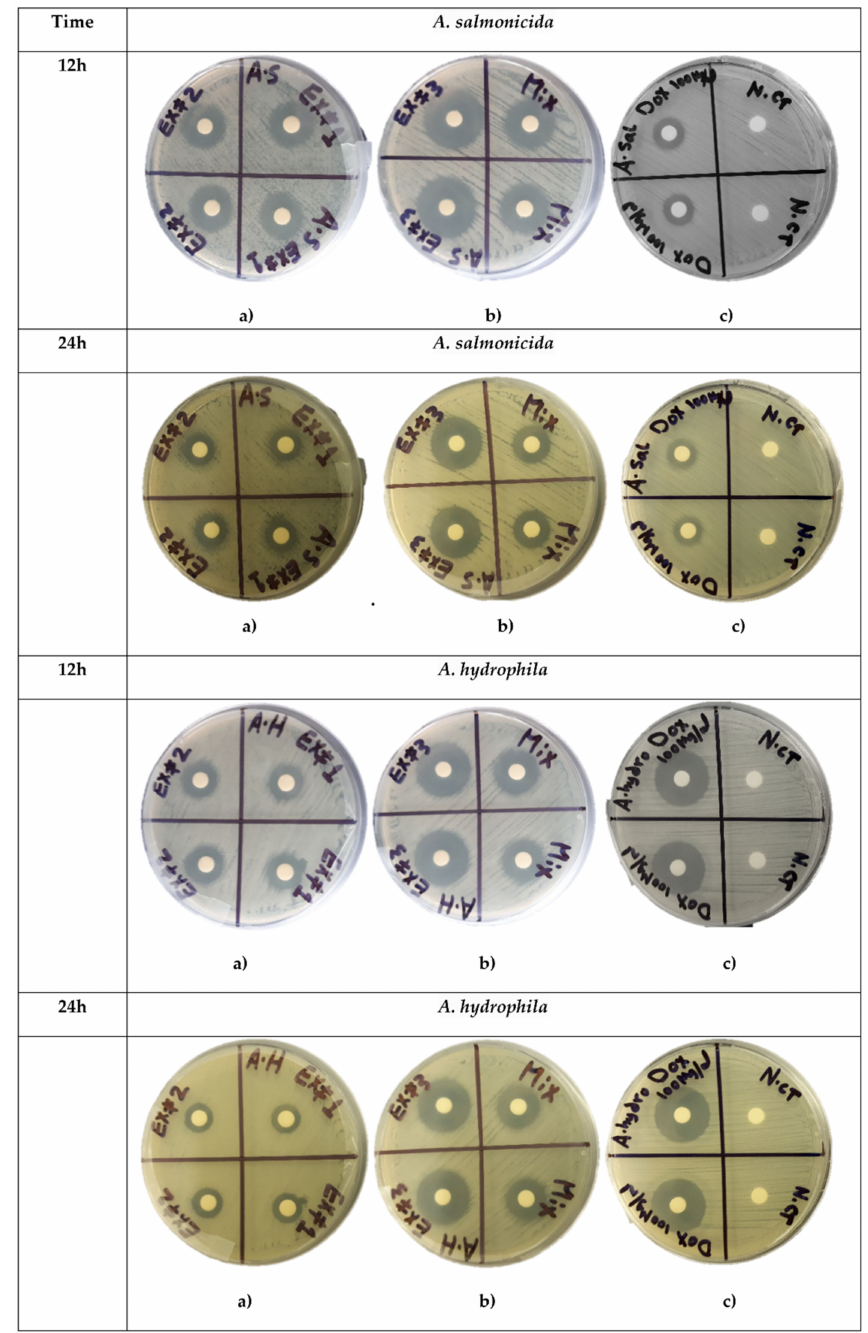
Figure 2. Susceptibility of A. hydrophila and A. salmonicida to three sequential extracts treatment determined by disk diffusion assay. Disks loaded in duplicates with 50 µ L of ( a ) AWME1 (Ex#1) and AWME2 (Ex.#2); ( b ) AWME3 (Ex.#3) and a mixture of the three SEs (Mix) at concentration 40 mg/mL; ( c ) Positive control (Doxycycline, 100 µ g/mL) and the extraction reagent as a negative control (N.ct). Inhibition Zone Diameter ranged from 11.4 ± 0.14 mm to 12.72 ± 0.22 mm for AWME1, while AWME2 against A. hydrophila a and A. salmonicida , respectively, by 24 h of incubation at concentration 40 mg/mL. IZD caused by AWME1 was lower significant (** p <